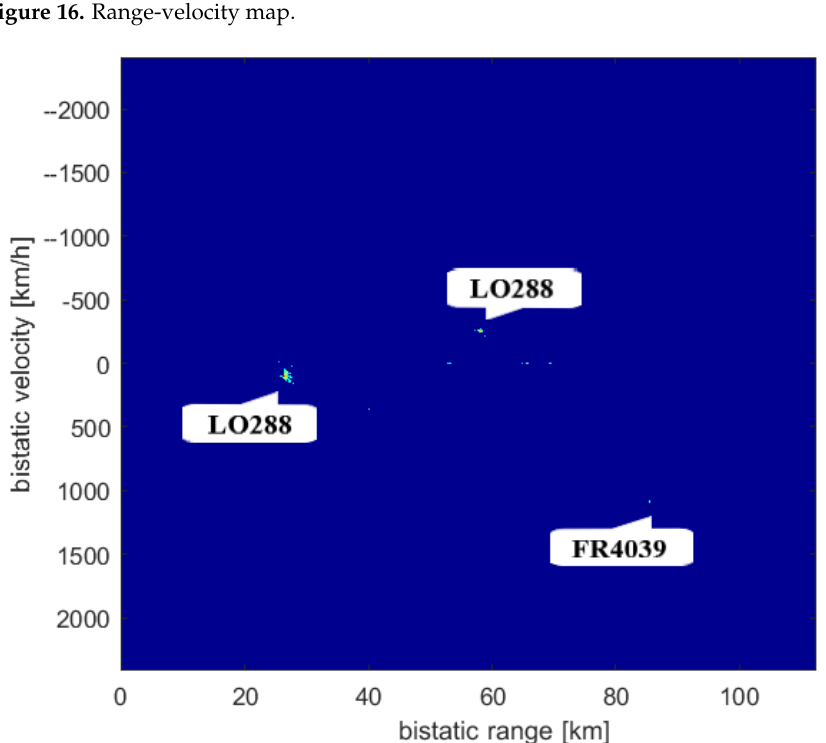
Figure 16. Range-velocity map.